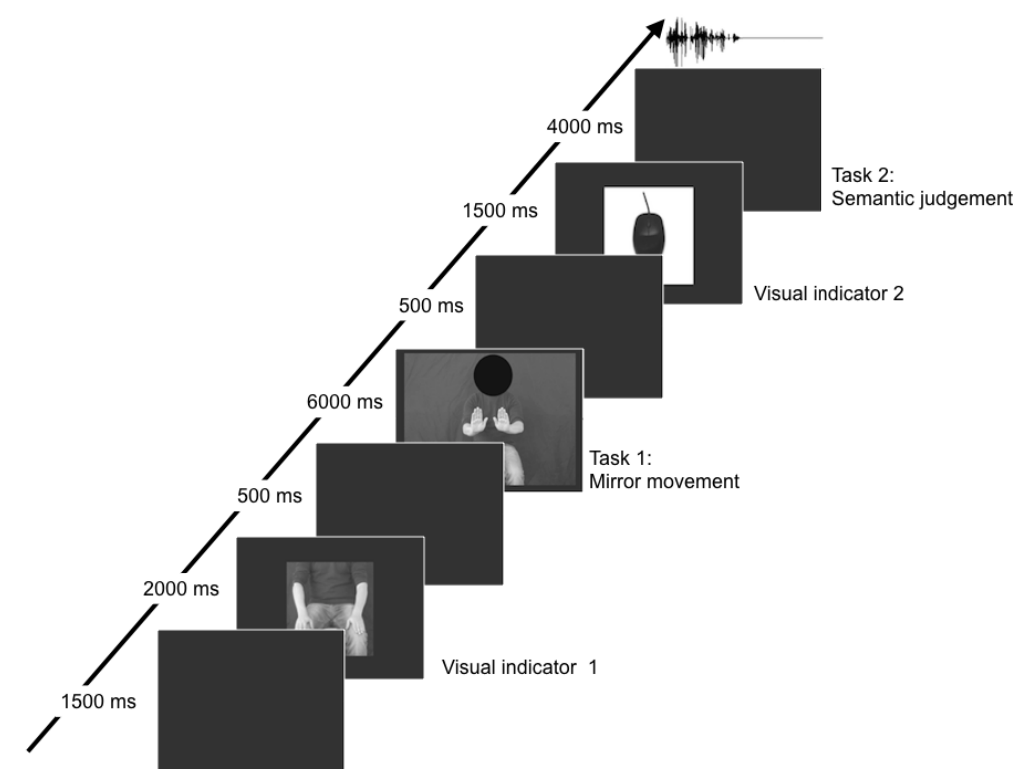
Figure 1. Duration and succession of events of a trial in milliseconds. Each trial started with a grey screen, followed by a picture displaying the starting position as instruction (visual indicator 1). Afterwards, a video was presented. In the movement condition, participants mirrored the movement presented in the video (task 1) and ended in the starting position with resting hands on their knees. In the no-movement condition, participants mirrored the video by staying in the starting position and sitting motionlessly. Next, a picture of a computer mouse signalled the participants to put their hand on the mouse (visual indicator 2). Subjects then listened to an auditory sentence and judged its plausibility via button press (task 2) (from [18], modified).